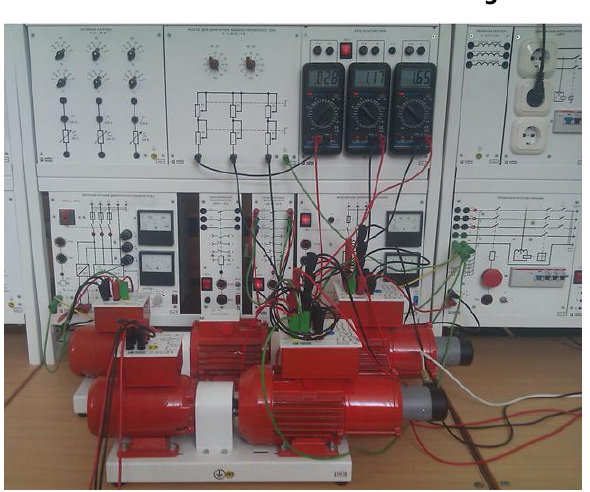
Figure 5. Electrical wiring.